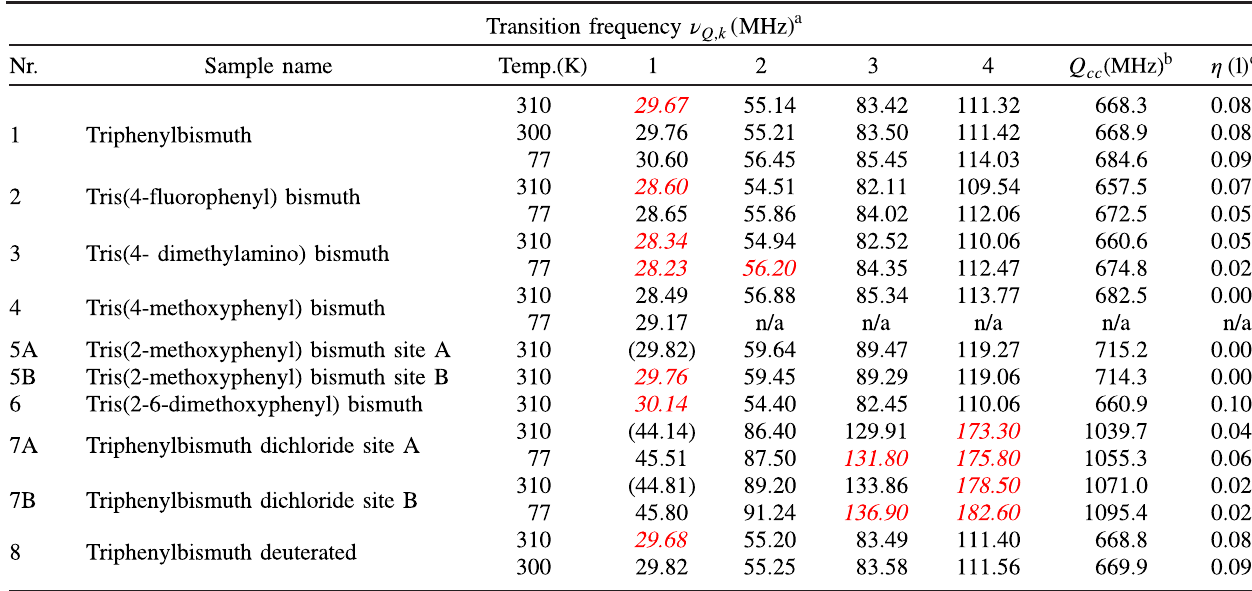
TABLE VI. Measured NQR transition frequencies ν Q;k and derived NQR parameter Q cc and η at different temperatures (310 K, 300 K, and 77 K) for eight Bi-aryl